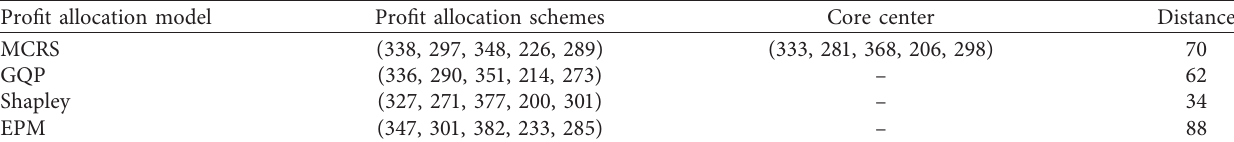
Table 11: Distance between schemes and the core center